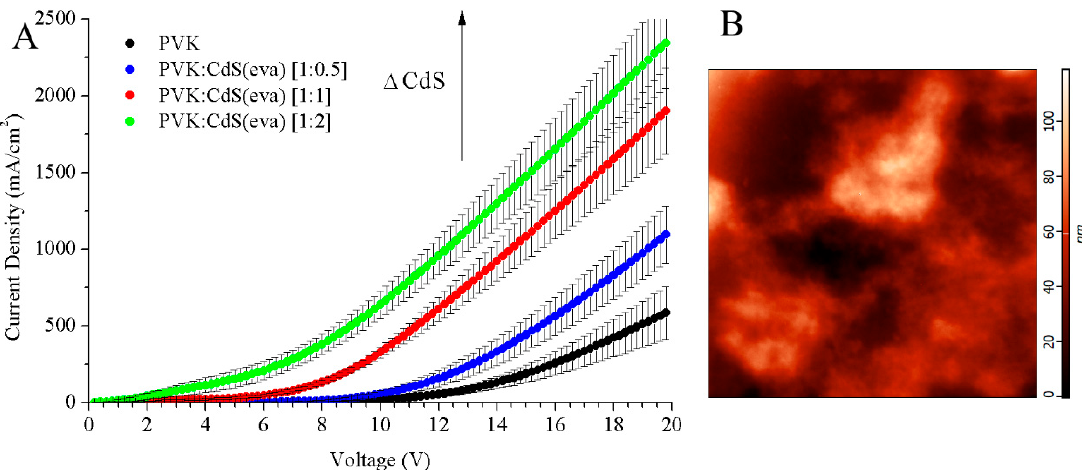
Figure 11. ( A ) J–V curves of the LEDs and ( B ) AFM image (area of 10 µm × 10 µm) corresponding to the hybrid LED with PVK:CdS(eva) [1:2] active layer. The color scale on the right indicates surface roughness.